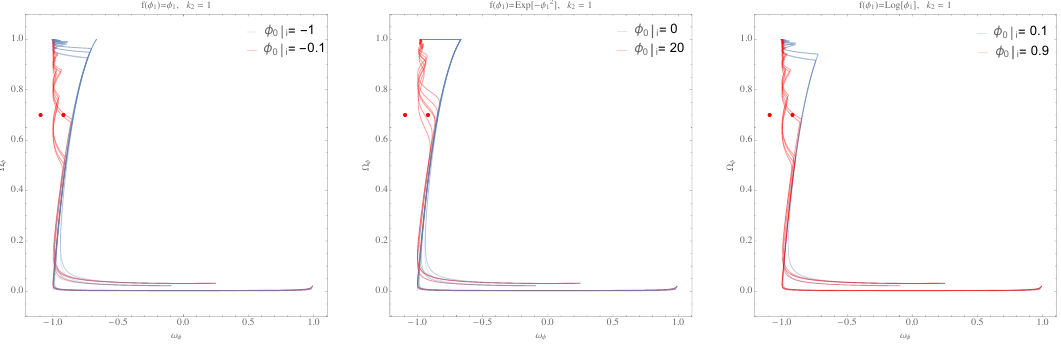
Figure 3 . ((cid:10) (cid:30) ; ! (cid:30) ) plane evolution for matter dominated initial conditions and k